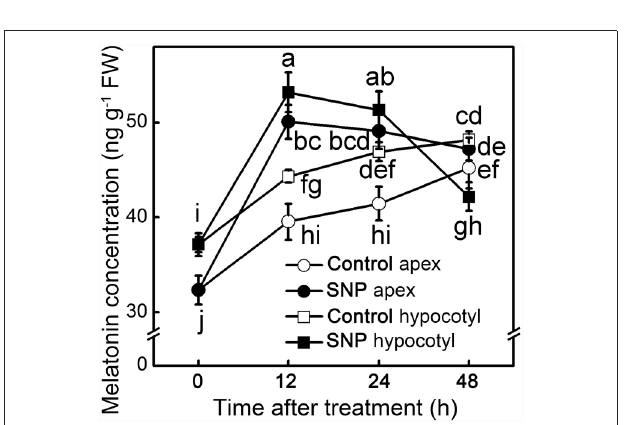
FIGURE 4 | MT concentration during the NO-induced adventitious root development. The primary root system was removed from hypocotyls of 10-days-old tomato seedlings. Explants were incubated with water (Control) and 50 µ M SNP (SNP). Data represent the means of five replicates ± SD, and different letters indicate significant difference ( p < 0.05).